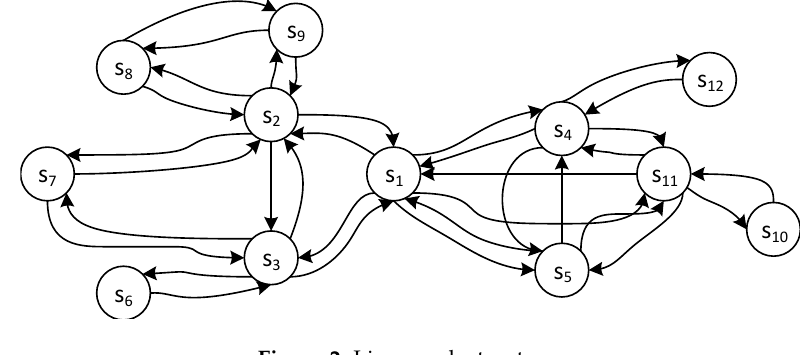
Figure 2. Line graph